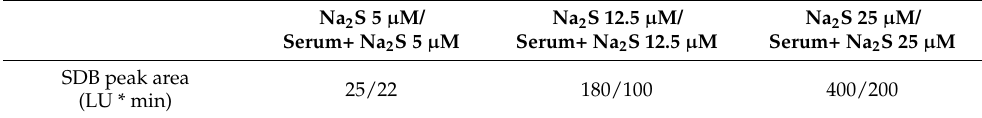
Table 2. SDB peak area of standard Na 2 S sample and spiked serum